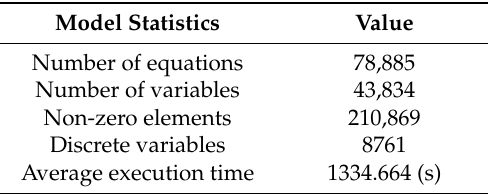
Table 12. Model statistics of the